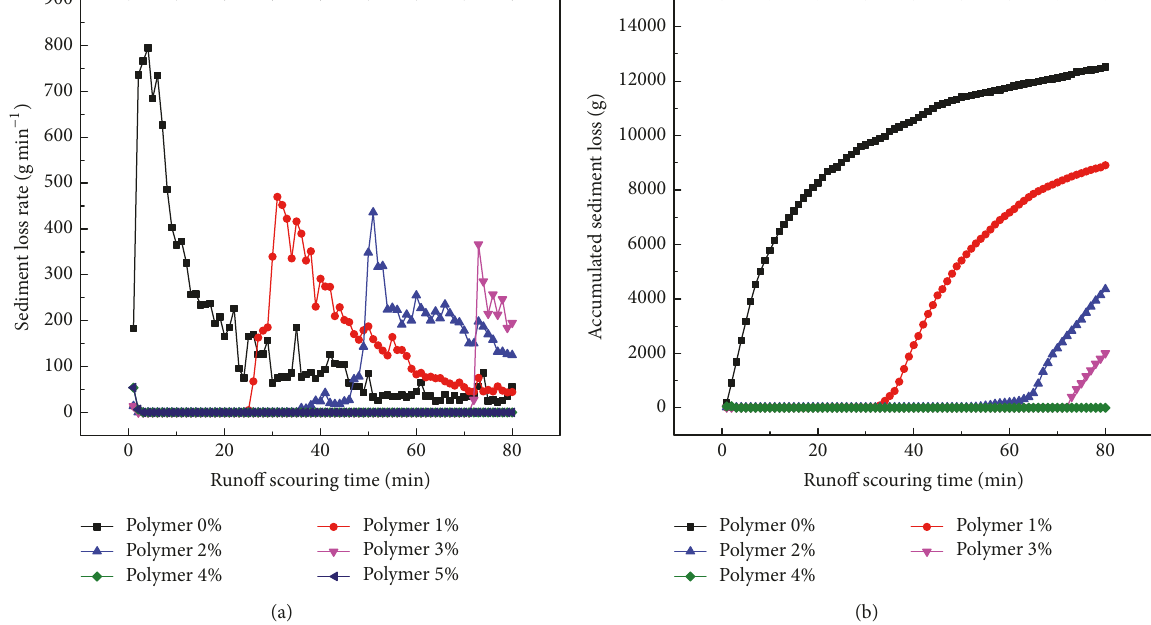
Figure 11: Results of runoff erosion test: (a) variation of sediment loss rate of specimens reinforced with polymer; (b) variation of accumulated sediment loss of specimens reinforced with polymer.